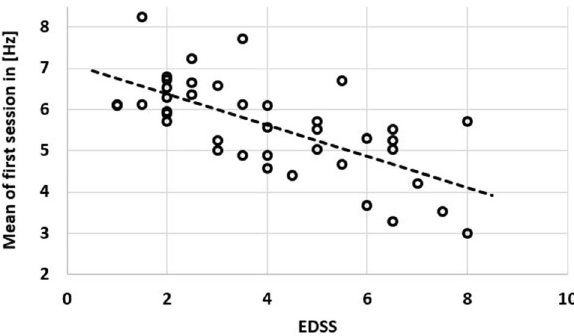
Figure 2. Scatter plot of EDSS and the mean of both hands and trials of the first session of finger tapping. The association was strong with an R 2 of 0.45 (p <